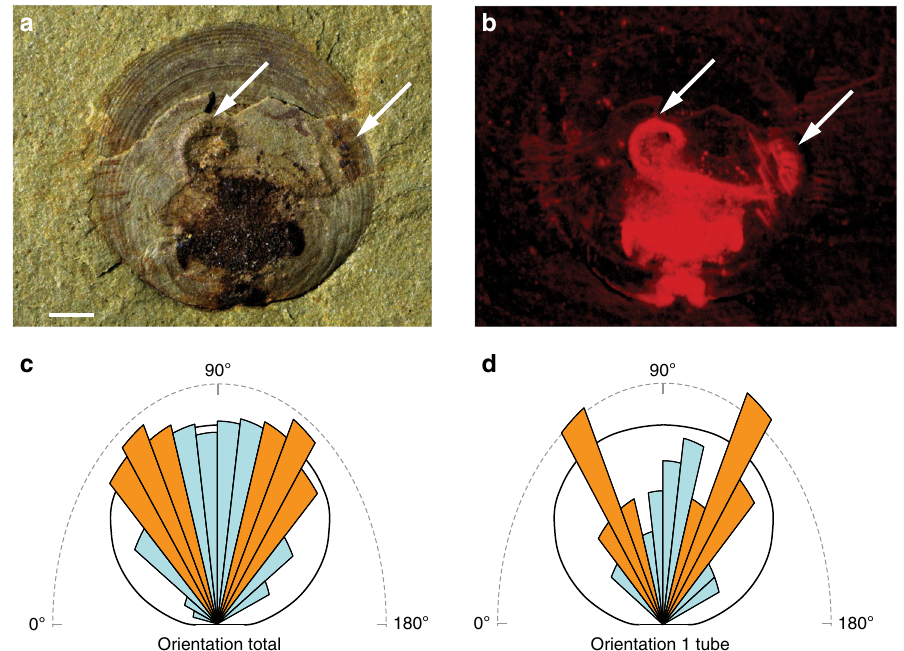
Fig. 3 Evidence demonstrating the associated encrusted tube-dwelling organisms were kleptoparasitic. a Shell interior of specimen ELI GB-N-0595A of N. wulongqingensis from Wuding (Supplementary Fig. 1a, Locality 2) showing the presence of a paired spirolophe lophophore (as indicated by white arrows). Scale bar is 1 mm. b Micro-XRF elemental mapping of Fe for ELI GB-N-SJJ-0595A provides a high contrast image of the spirolophe lophophore (as indicated by white arrows). c , d Rose diagrams of attached tube orientation for: c All measured individuals of N. wulongqingensis ( n = 146) and; d N. wulongqingensis individuals with only one attached tube ( n = 31). Each division represents a 10° interval. Intervals colored in orange are those that correspond to the inhalant laminar currents generated by N. wulongqingensis . For all numbers of attached tubes, orientations that align with inhalant laminar currents are preferred but for individuals with only one attached tube, where the symbiont has all available orientations still available, orientations that align with the inhalant laminar currents are strongly